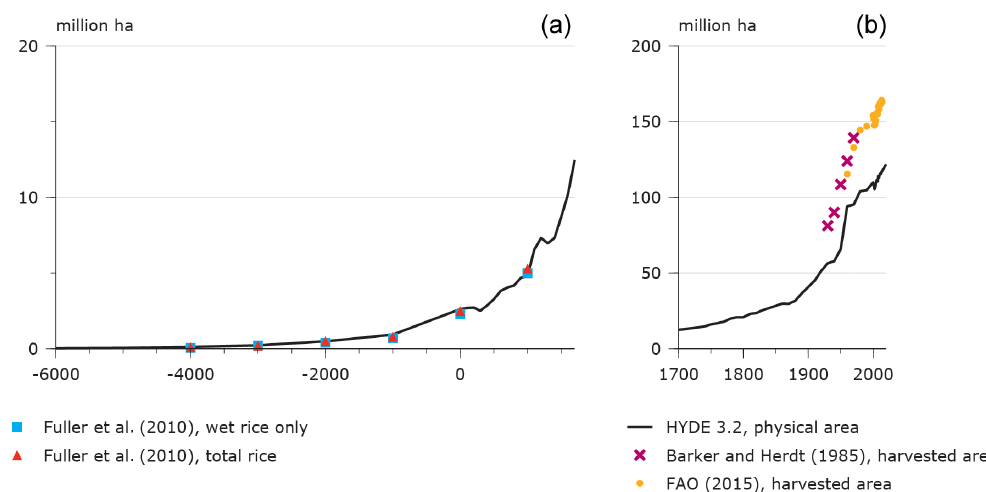
Figure 6. Historical (physical) rice area estimates for two periods: 6000BCE–1700CE (a) and 1700–2010CE (b) .